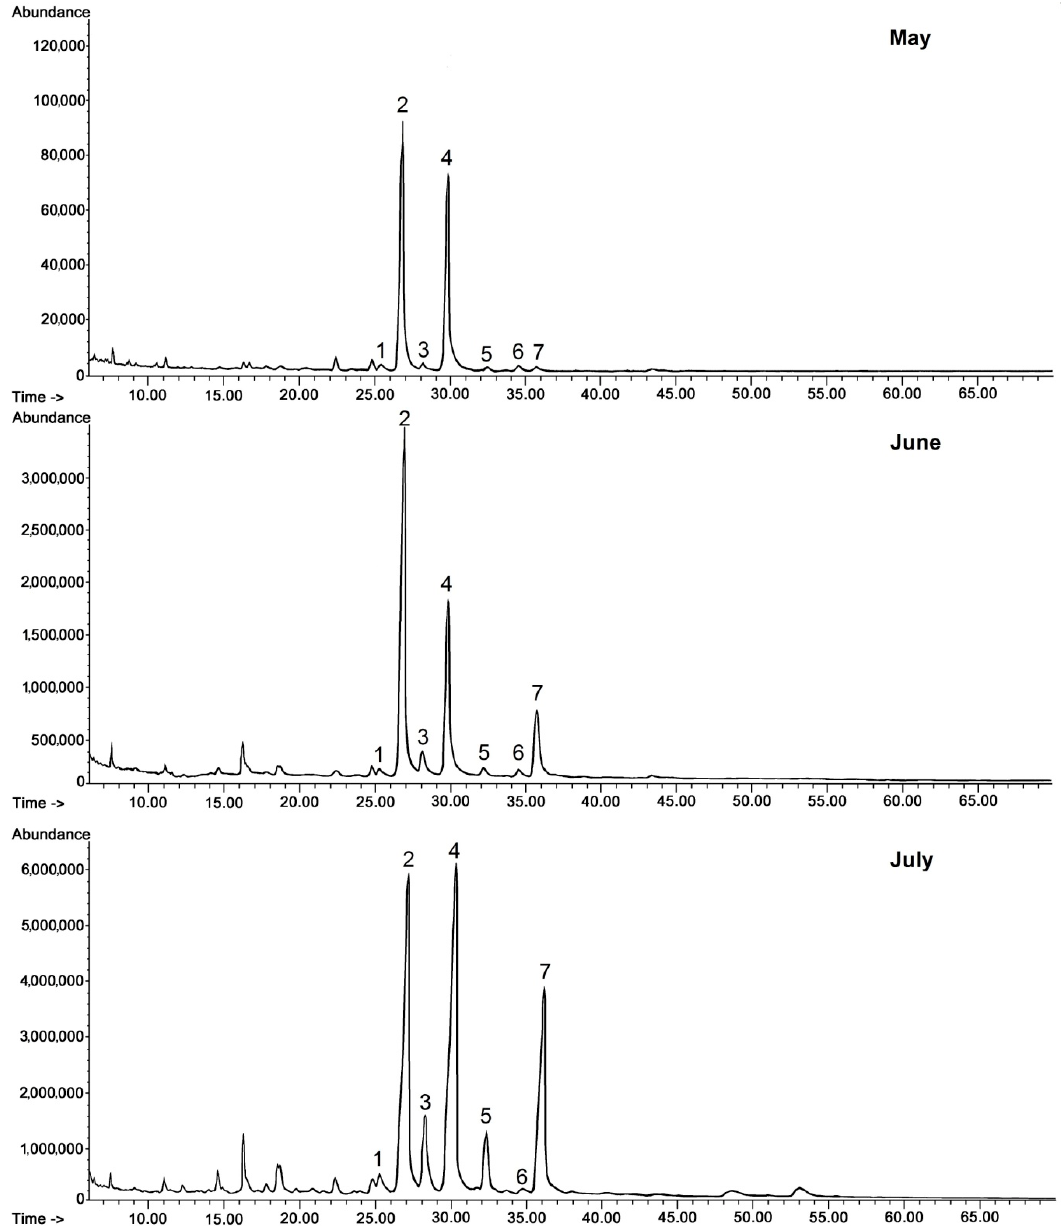
Figure 3. GC-FID chromatograms of the fraction of triterpenoid acids (after methylation) obtained from chloroform extracts of cuticular waxes of bilberry fruit harvested in three developmental stages (young berries in May, unripen full-size berries in mid-June, and ripen berries in early July). Methyl esters of: 1—3-oxo-oleanolic acid, 2—oleanolic acid, 3—3-oxo-ursolic acid, 4—ursolic acid, 5—maslinic acid, 6—corosolic acid, 7—oleanolic acid